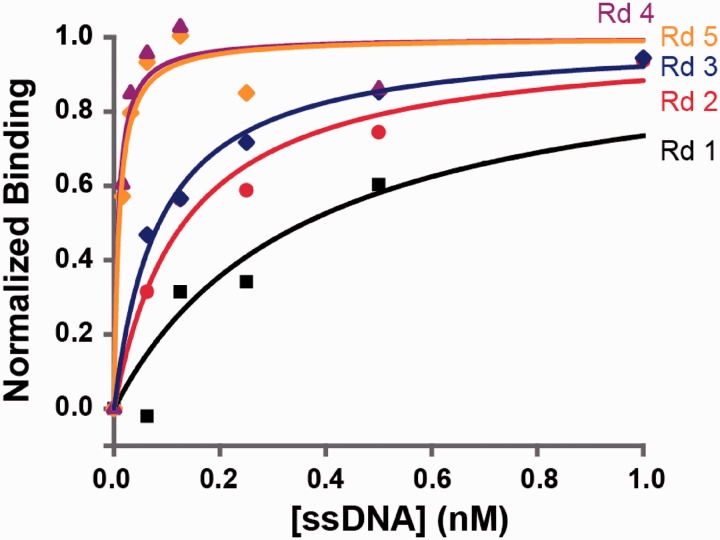
Binding affinities of enriched aptamer pools for 5 rounds of selection. Measurements for each round are based on background-subtracted fluorescence values from a bead-based binding assay, scaled to saturation intensity. Binding affinity against thrombin increased over four rounds of selection, from an apparent Kd of 0.361 nM in Round 1 to 0.0075 nM in Round 4, before plateauing in Round 5.